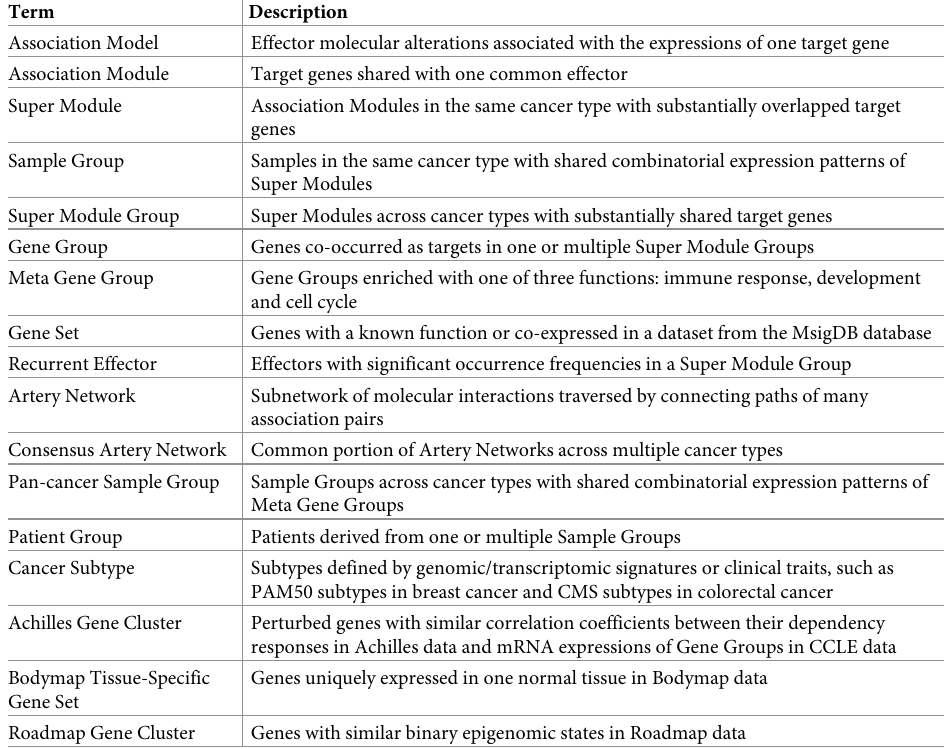
Table 2. Summary description of subunits in